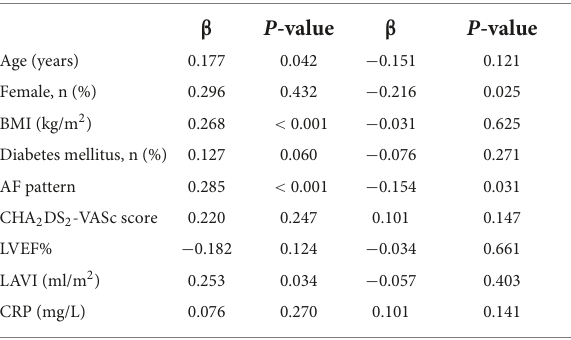
TABLE 4 Correlation between LA-EAT volume and attenuation and clinical variables. LA-EAT volume LA-EAT